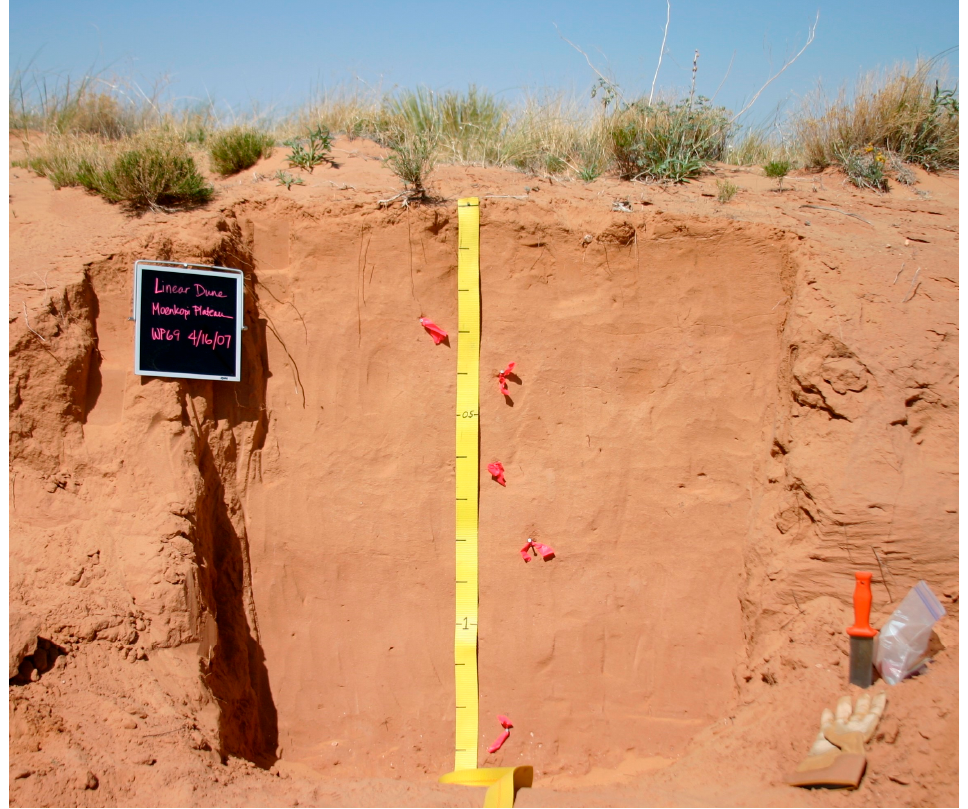
Figure 9. Qe3 (0–73 cm) over Qe2 (below 73 cm) soil profile at WP69. Soil horizonation is weak throughout and soil structure is not evident in the photo. See Table 4 for soil description.